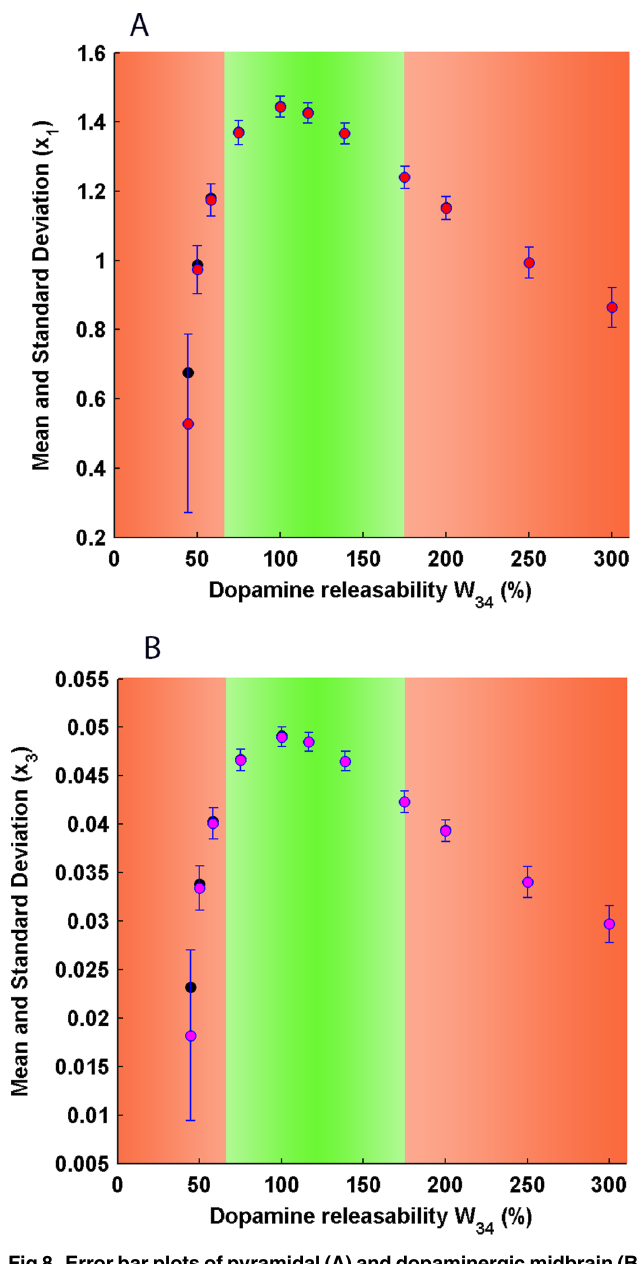
Fig 8. Error bar plots of pyramidal (A) and dopaminergic midbrain (B) activity under stochastic mesocortical dynamics during delay interval. The solid red (magenta) circles represent working memory- associated mean pyramidal (midbrain) activities and the blue error bars denote standard deviations around the mean activities at different dopamine releasability W 34 , in the presence of noisy circuit dynamics. The solid black circles represent pyramidal (midbrain) activities obtained from deterministic mesocortical dynamics and constitutes the signal profile. In the optimal region (green zone), the mean pyramidal (midbrain) activity is associated with least noisy fluctuations and coincides with the pyramidal (midbrain) activity of the signal profile. In the region of low dopamine releasability (left, red zone), the pyramidal (midbrain) activity shows dramatic fluctuations such that the mean activity significantly deviates away from the sustained-firing state and shifts towards the spontaneous-activity state. In the region of high dopamine releasability (right, red zone), there does not occur a noticeable deviation of the mean pyramidal (midbrain) activity from the sustained firing state, but, indeed contains significant fluctuations as compared to the optimal region. As evident, the pyramidal and midbrain activity demonstrates a tightly-linked response with regard to their relative noise